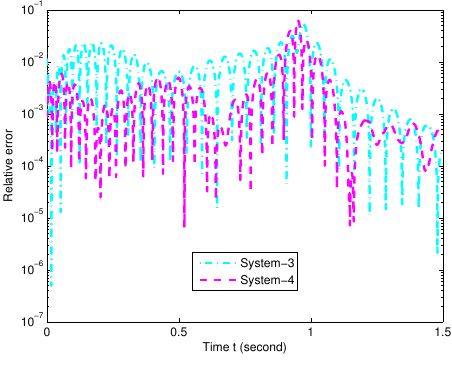
Figure 4. Relative errors in Example